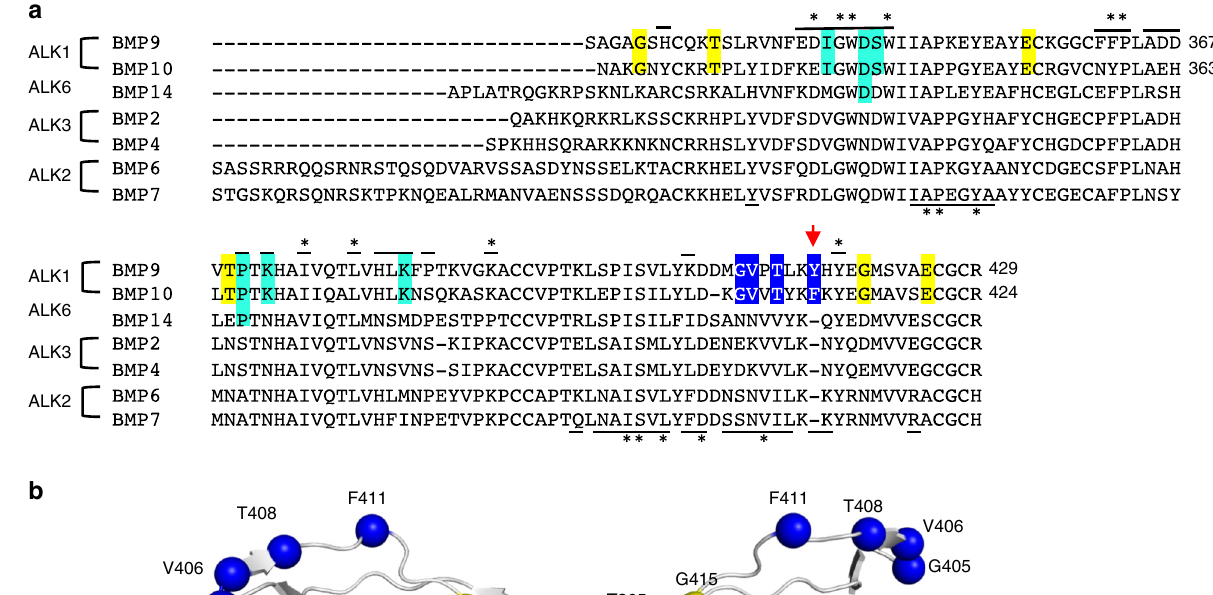
interface is conserved across all BMPs and mostly hydrophobic in nature (Fig. 4f). From the ALK1 side, residues H73, E75, R78 and R80 interact with amino acids that are unique to BMP9 and BMP10 hence de fi ne the ALK1 speci fi city (Fig. 4c, d). Interest- ingly, these ALK1 residues are located near or within the two loops of ALK1 that have signi fi cantly different conformation